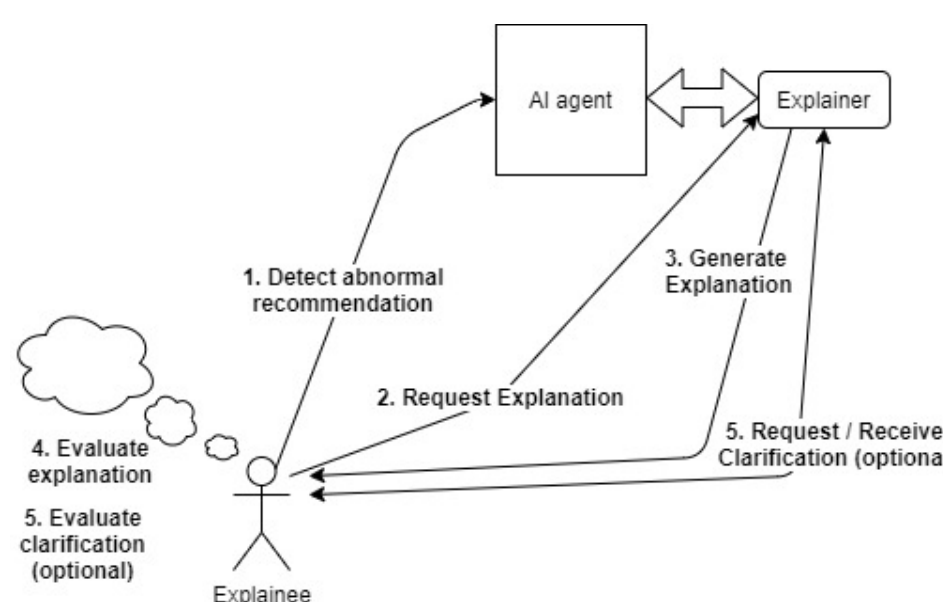
Figure 1. The AI explanation cycle.